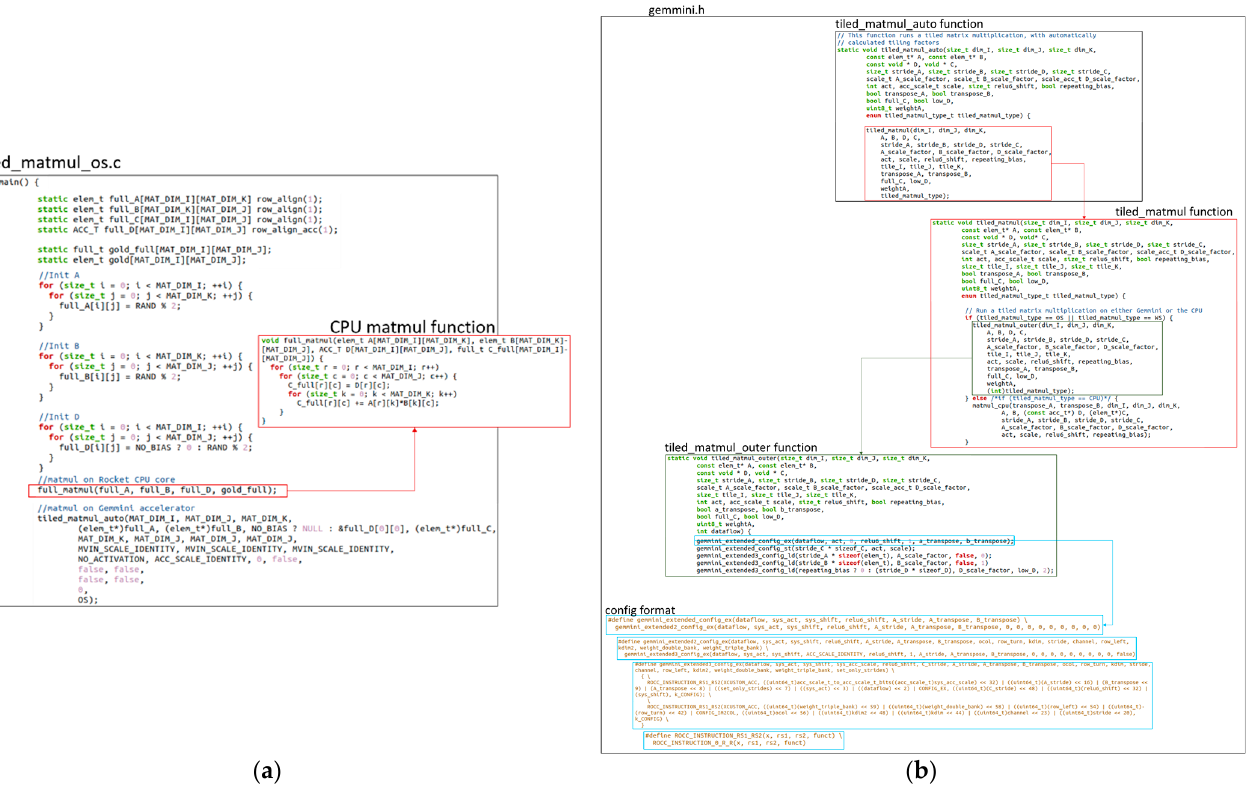
Figure 14. Gemmini software code file: ( a ) program source file; ( b ) Gemmini header file. The tiled_matmul_os.hex and tiled_matmul_ws.hex files together with the output